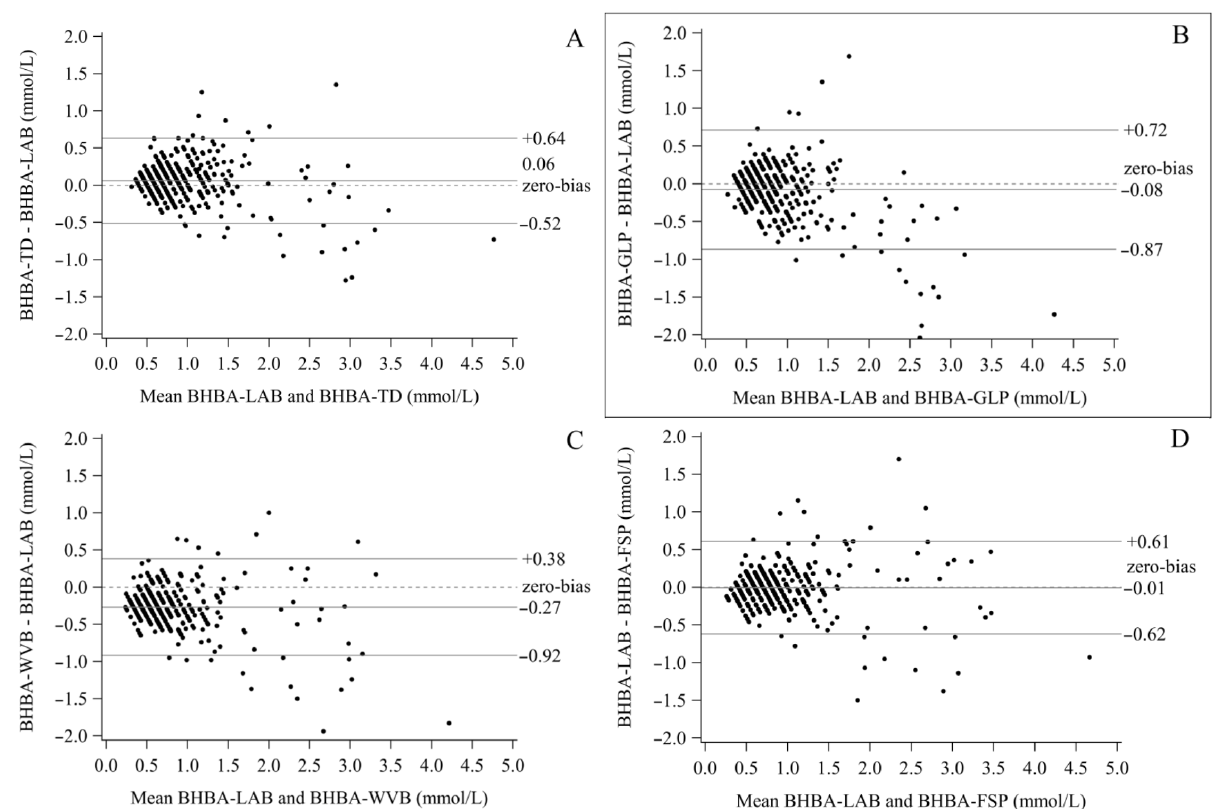
Figure 2. Bland–Altman plot. Differences of BHBA concentrations in whole blood measured by TD 1 ( A ), GLP 1 ( B ), WVB 1 ( C ), FSP 1 ( D ), and BHBA concentrations in serum measured with the reference method in the laboratory plotted against their means. The middle solid line equals the mean differences of the two methods, the dashed line represents the zero-bias line where the difference is 0 and equals no bias. The outer solid lines represent the mean ± 2 SD. 1 TD = BHB- Check (TaiDoc Technology Corporation, Taiwan, CHN); GLP = GlucoMen LX Plus (A. Menarini Diagnostics, Berlin, DE); WVB = WellionVet BELUA (MED TRUST GmbH, Ottendorf-Okrilla, DE); FSP = Freestyle Precision Neo (Abbott GmbH & Co. KG, Wiesbaden,